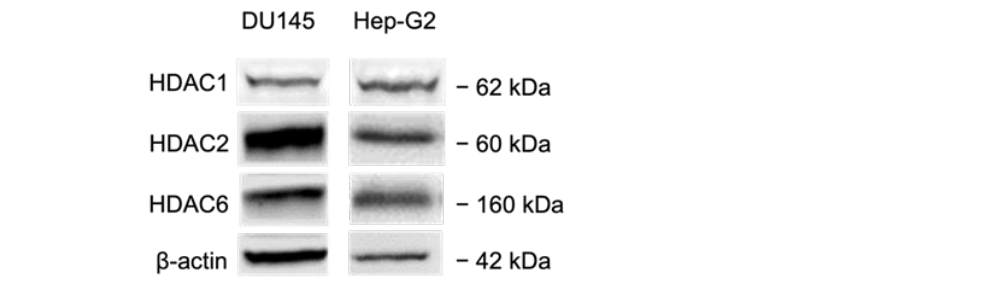
Figure 8. Western blot determined expression of HDAC1, HDAC2, and HDAC6 in DU145 prostate cancer and Hep-G2 liver cancer cells.